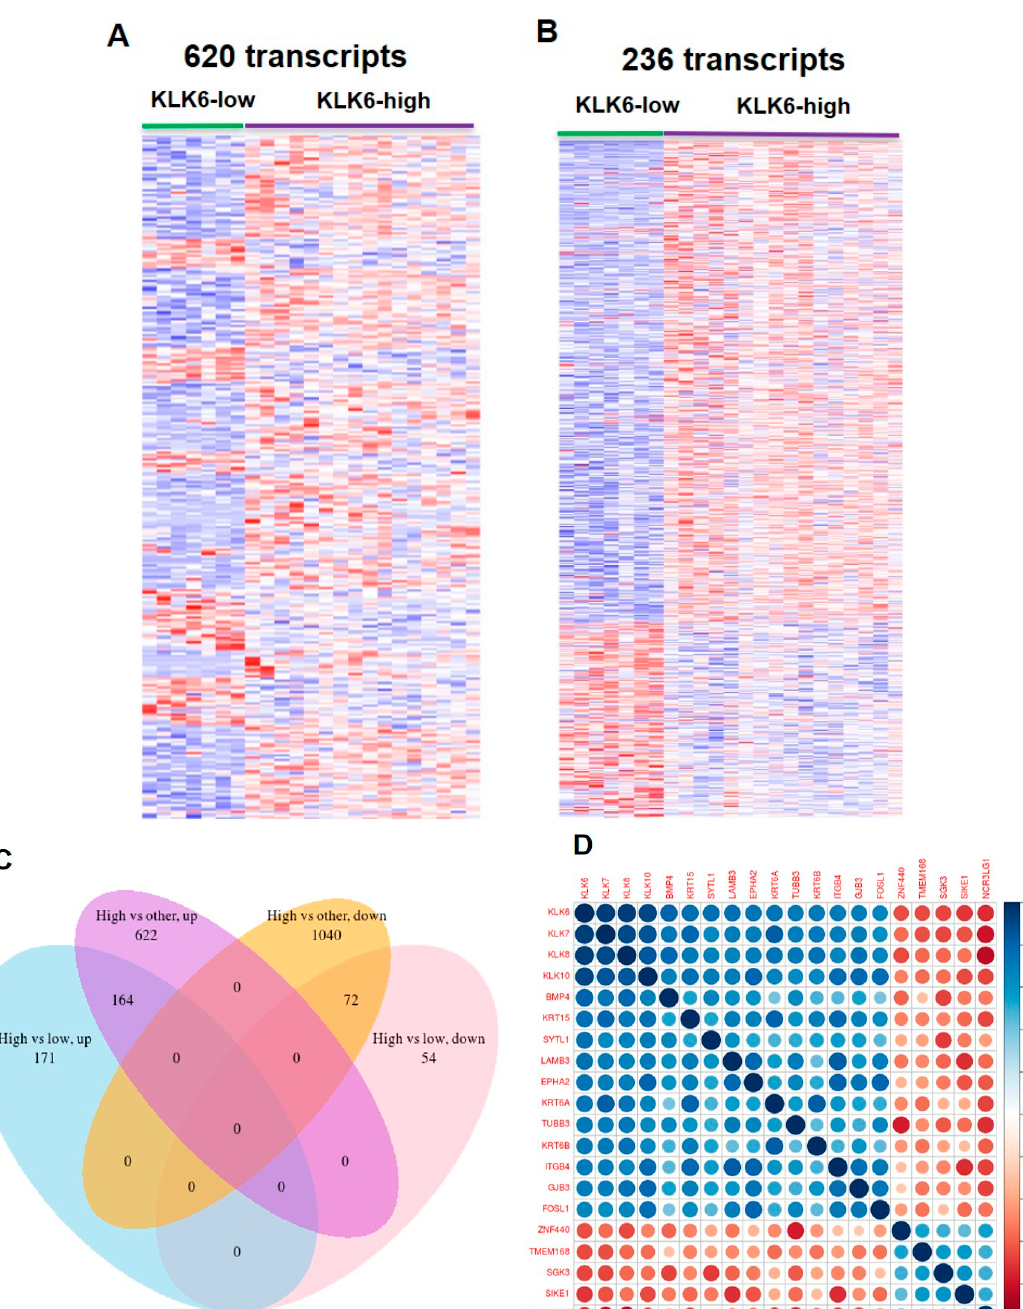
Figure 3D. The highly associated genes include the members of kallikrein family ( KLK7, KLK8, KLK10, and KLK11 ), keratins ( KRT80, KRT6A, KRT6B, KRT19, KRT15, KRT19 ), ex- tracellular matrix proteins, vesicle-mediated protein trafficking, and signaling genes, e.g., (Table S3C).